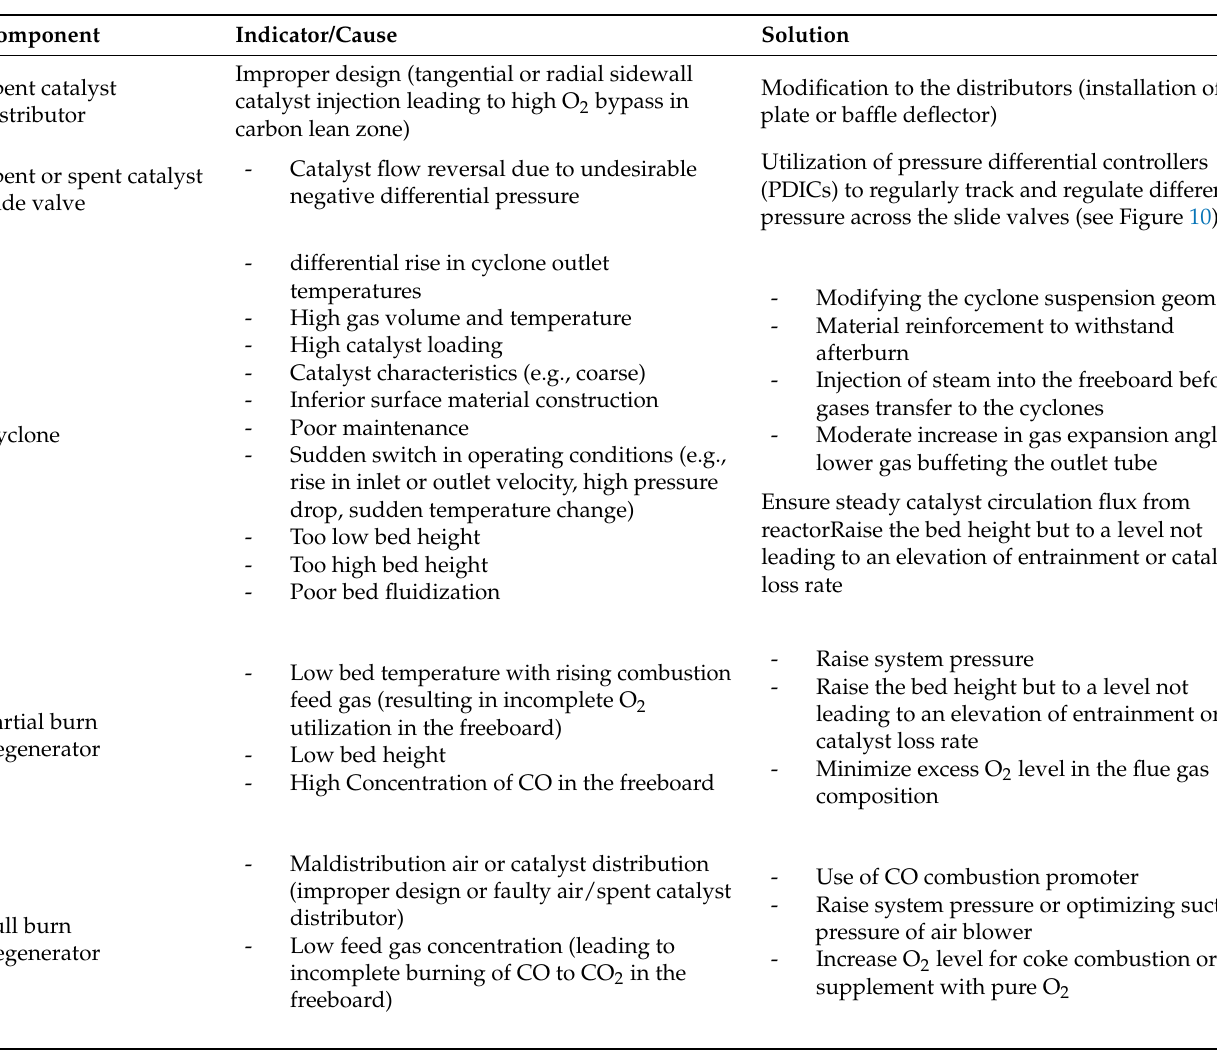
Table 7. Summary of afterburn causes and potential solutions in FCC